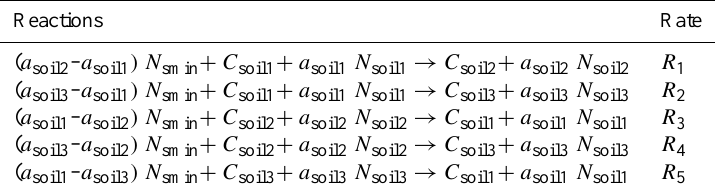
Table 3. CENTURY decomposition model of soil organic